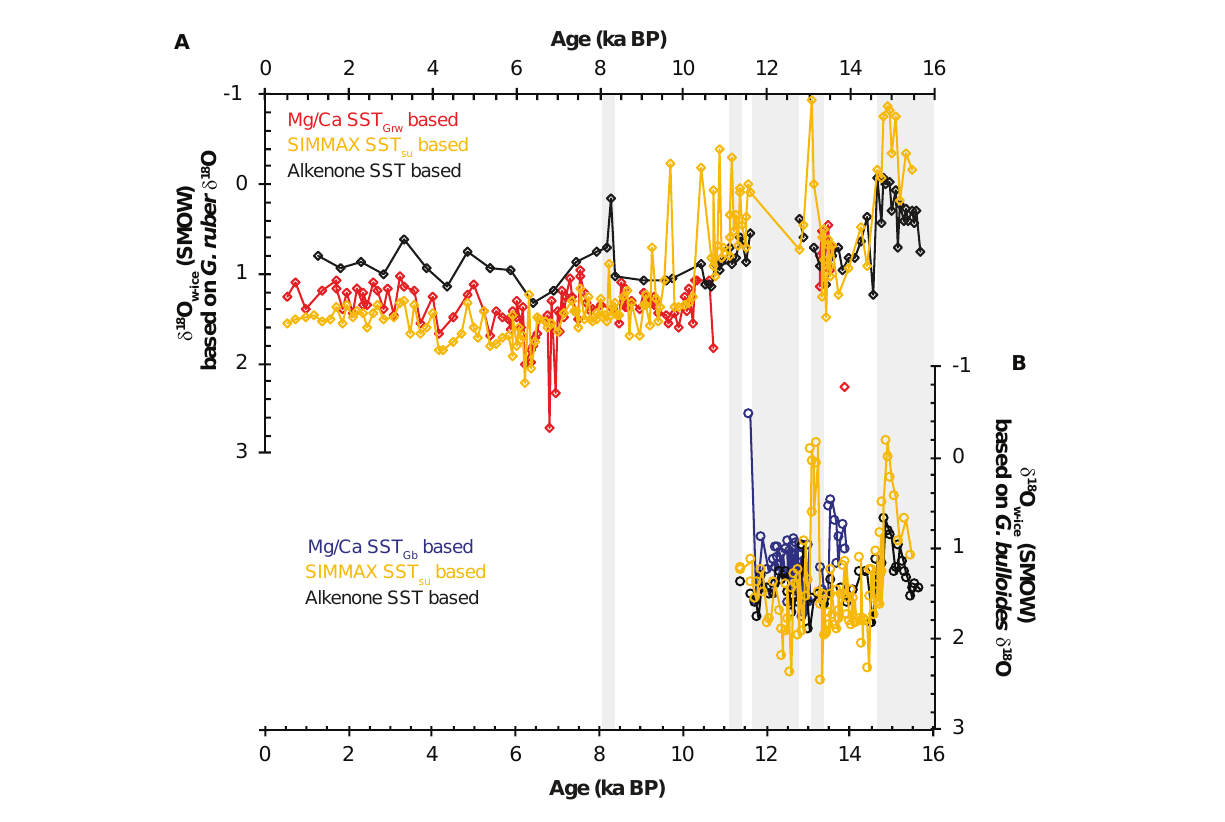
FIGURE6 Comparison between different δ 18 O w − ice reconstructions, (A) comparing δ 18 O of G. ruber combined with SIMMAX summer SST (yellow), U K (cid:48) 37 SST (black), and Mg/Ca SST Gr (red). (B) Comparison of reconstructions based on δ 18 O of G. bulloides combined with SIMMAX summer SST (yellow) U K (cid:48) 37 SST (black), Mg/Ca SST Gb (dark